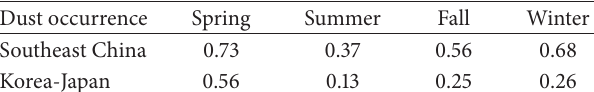
Table 4: Comparison of seasonal dust occurrences in southeast